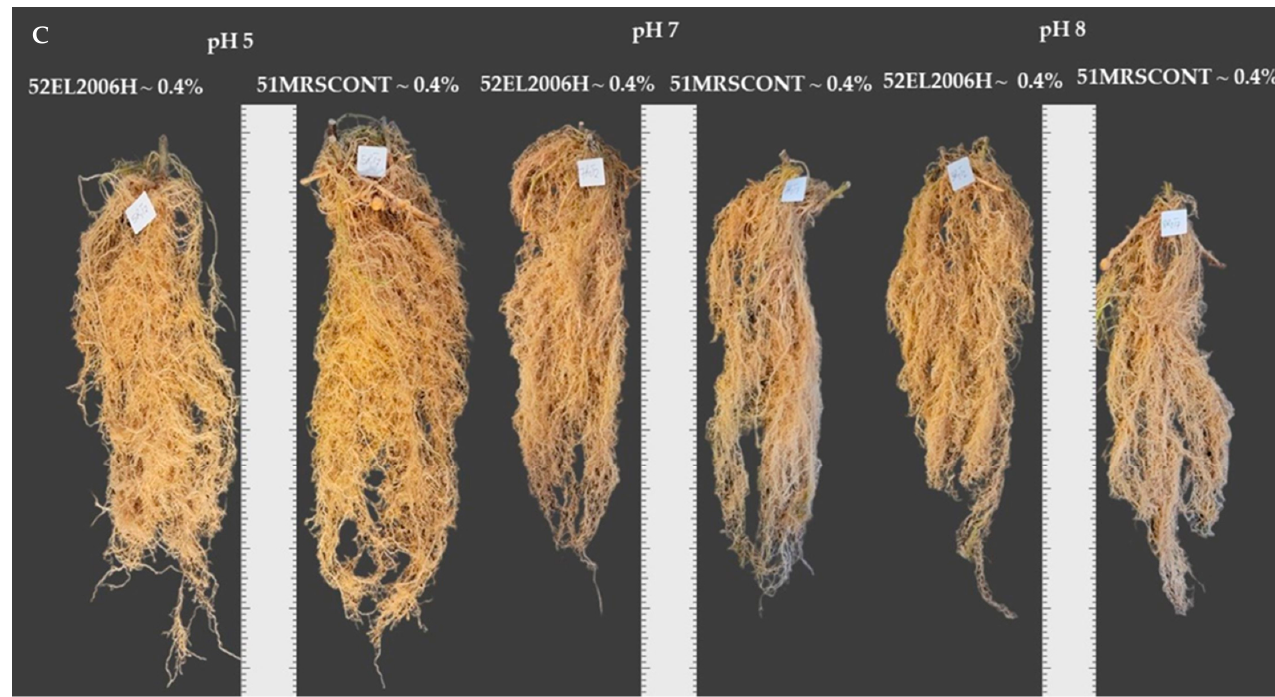
Figure 3. Visual variations of potato roots from plants grown at pHs 5, 7, and 8 in response to CFS from B. subtilis EB2004S cultured at pH 5 ( A ) and L. helveticus EL2006H ( B , C ).